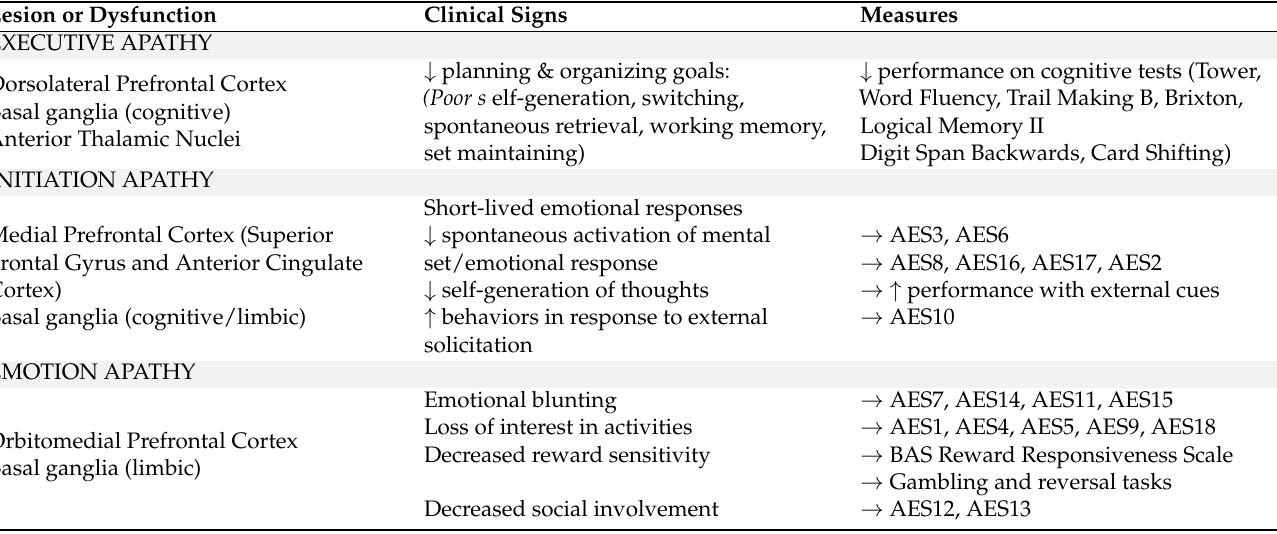
Table A2. Apathy subtypes, corresponding neural and functional impairments, and suggested measures. Lesion or